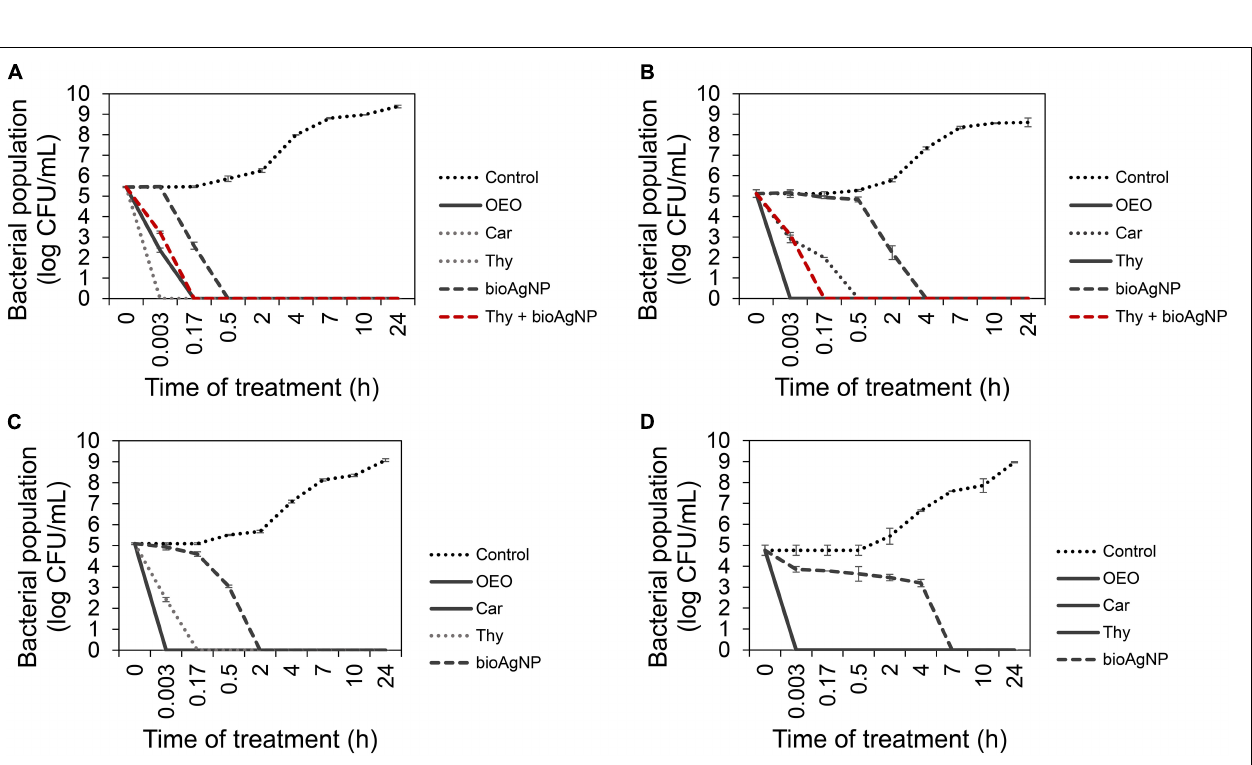
FIGURE 2 | Time-kill curves of Gram-negative and Gram-positive bacterial strains exposed to oregano essential oil (OEO), carvacrol (Car), thymol (Thy), and the bioAgNP individually at minimal bactericidal concentration (MBC), and in the combination containing Thy (0.5 × MIC) and bioAgNP (0.5 × minimal inhibitory concentration, MIC). Control indicates bacterial growth with no antimicrobial. (A) Escherichia coli ATCC 25922. (B) KPC-producing Klebsiella pneumoniae . (C) Carbapenem-resistant Acinetobacter baumannii . (D) Methicillin-resistant Staphylococcus aureus (MRSA) N315. Values of log10 colony-forming units (CFU)/ml are the mean ± standard